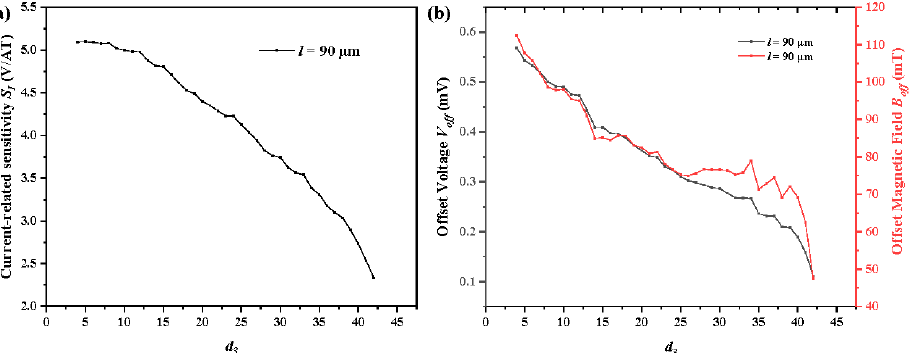
Figure 7. Current-related sensitivity S I ( a ), offset voltage V off and offset magnetic field B off ( b ) of d 3 from 4 to 42 μm with length l set to 90 μm. The distances of C3 to C4, C4 to C5, C1 to the left boundary, and C7 to the right boundary are fixed.